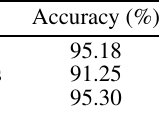
Table 8. Classification accuracies on UCM when different subsets of MLRSNet are used for DA training of the feature extractor.